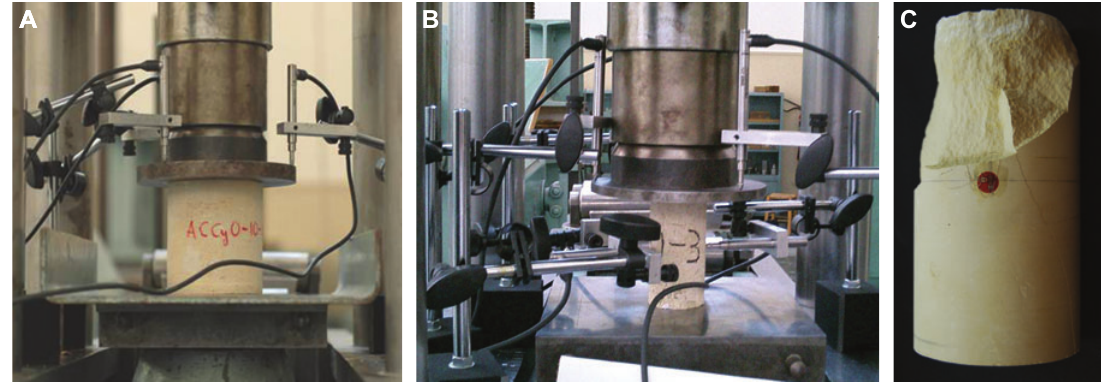
Figure 1 The experimental set-up with only vertical (A) and with vertical and horizontal LVDTs (B) (the indications of the latter were not evaluated due to their scattering). (C) A typical Cyprus stone fractured specimen with strain gauge rosettes. Four rosettes were used at the ends of two mutually perpendicular diameters.